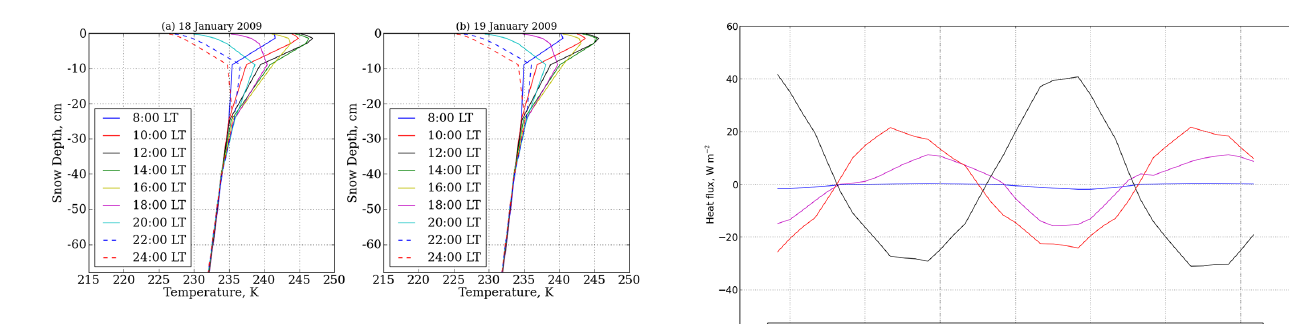
Figure 3. Simulated vertical temperature profiles for the upper layer of the snowpack on 18 June 2009 (left panel) and on 19 June 2009 (right panel) for several local times (LT = GMT + 8).